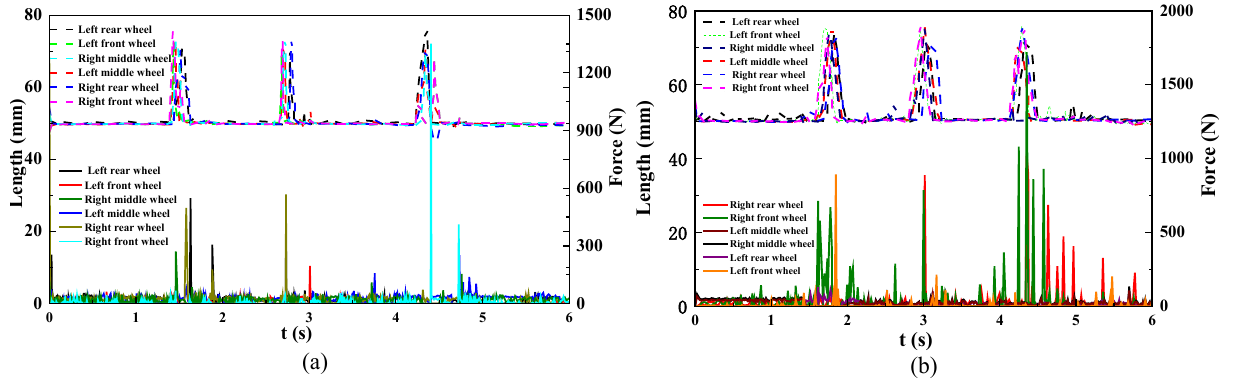
Figure 13. Simulation results: the movement track of each wheel center and the contact force of each wheel on complex road conditions: ( a ) Floating mobile chassis; ( b ) No floating mobile chassis.